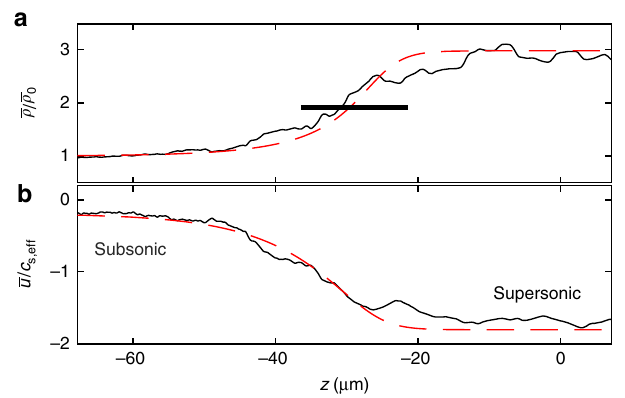
Fig. 6 Shock pro fi le. a Filtered density and b velocity pro fi les from 3D numerical simulation (black solid) in units of the downstream, subsonic fl ow density (cid:1) ρ and associated sound speed c s,eff = 1.35 mm s − 1 . The red 0 dashed curves correspond to an exact, viscous traveling wave solution of the piston problem for the 1D shallow water equations with an effective nondimensional viscosity parameter (see Methods) that reveals the shock structure and compares favorably to the experimentally measured shock width 15.5 μ m (horizontal segment). This pro fi le corresponds to Fig. 3 at the